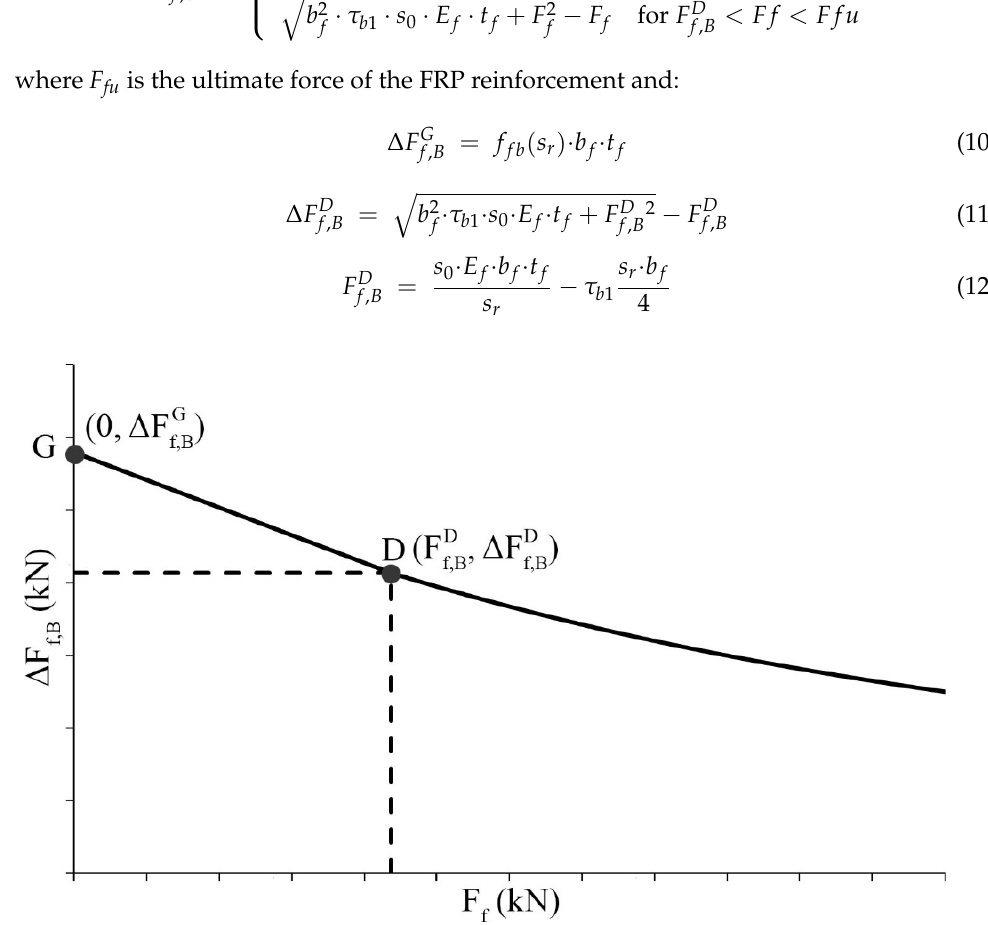
Figure 4. Maximum resisted increment of FRP force due to bond contribution. The term related to the bond friction ( Δ F f,F ) is calculated using Equation (13). This term considers the friction that is produced in the surfaces where the debonding process starts, before the failure of the whole element between cracks.